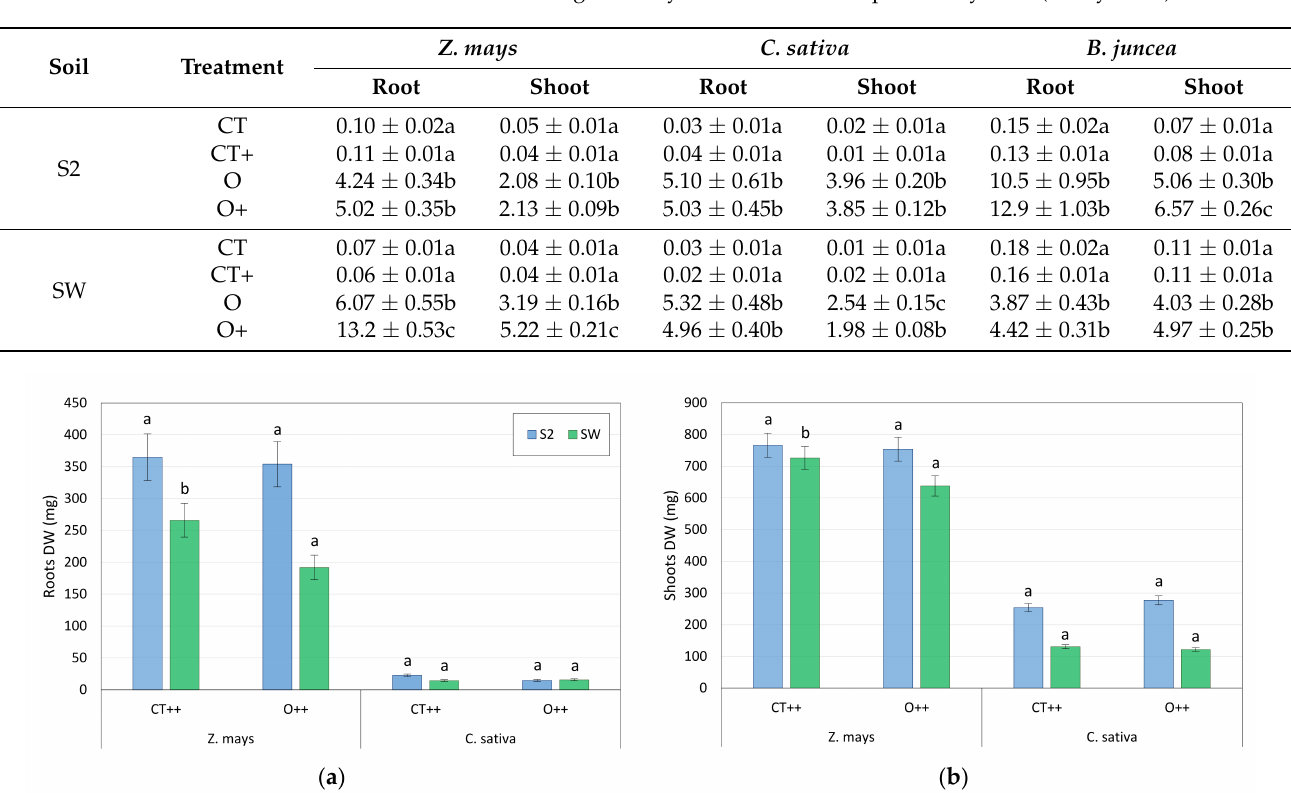
Figure 7. Arsenic total uptake by ( a ) roots and ( b ) shoots of Z. mays , C. sativa, and B. juncea grown on soil control (CT) and As-contaminated soil treated with oxalate (O). The addition of PGPR bacteria (first set of isolates) is indicated with the “+” sign. Values are the mean of three replicates, and the error bars show the standard deviation. Values with different letters are significantly different at the 5% probability level (Tukey’s test). Table 4. Arsenic concentration (mg kg − 1 ) in roots and shoots of Z. mays, C. sativa, and B. juncea grown on soil control (CT) and As-contaminated soil treated with oxalate (O). The addition of PGPR bacteria (first set of isolates) is indicated with the “+” sign. Values are reported as mean ( n = 3) ± SD. Values with different letters are significantly different at the 5% probability level (Tukey’s test).